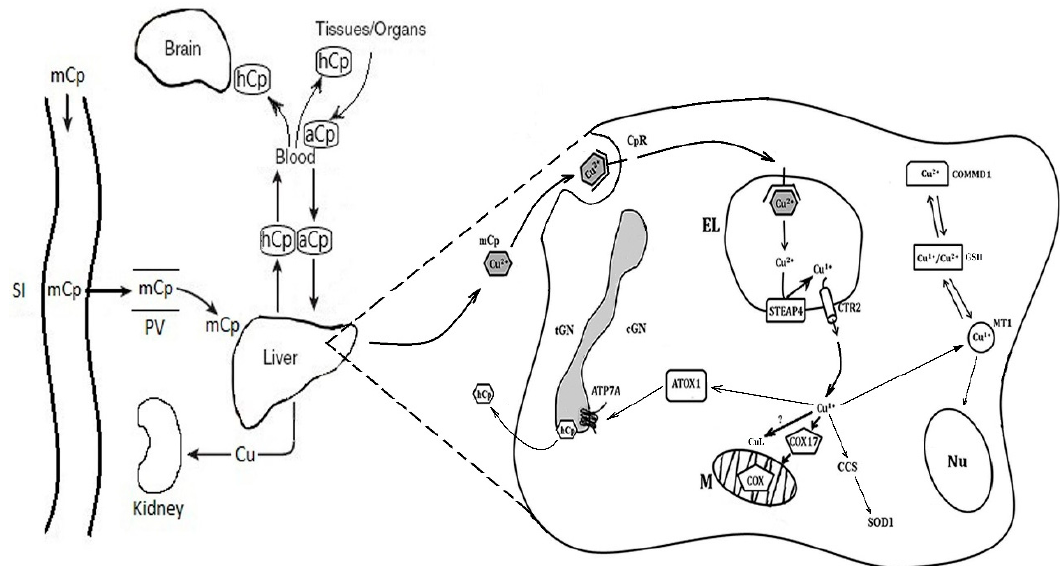
Figure 1. Cartoon scheme of copper turnover in the hepatocytes of newborns. In newborns, milk Cp enters into the gastrointestinal tract and, due to transcytosis, transfers into the bloodstream without modification. Then, it binds with the hepatic Cp receptor and proceeds into the endolysosomes. At pH > 5, the Cu(II) ions are dissociated from the milk Cp molecule, and Cu(II) is reduced to Cu(I) by STEAP4 and imported by CTR2 into the cytosol. Here, Cu(I) is redistributed between Cu(I)-chaperones to be delivered to COX, SOD1, and Cp. In the cytosol, copper is bound by MT1, is involved with the redox cycle MT/GSH, and can be deposited in the hepatocytes. CuL binds the Cu(I) ions, and they are transported into the mitochondria to support copper balance in cytosol. Because MT is found in the mitochondria and nucleus, it is possible that it transfers copper into the nucleus and the